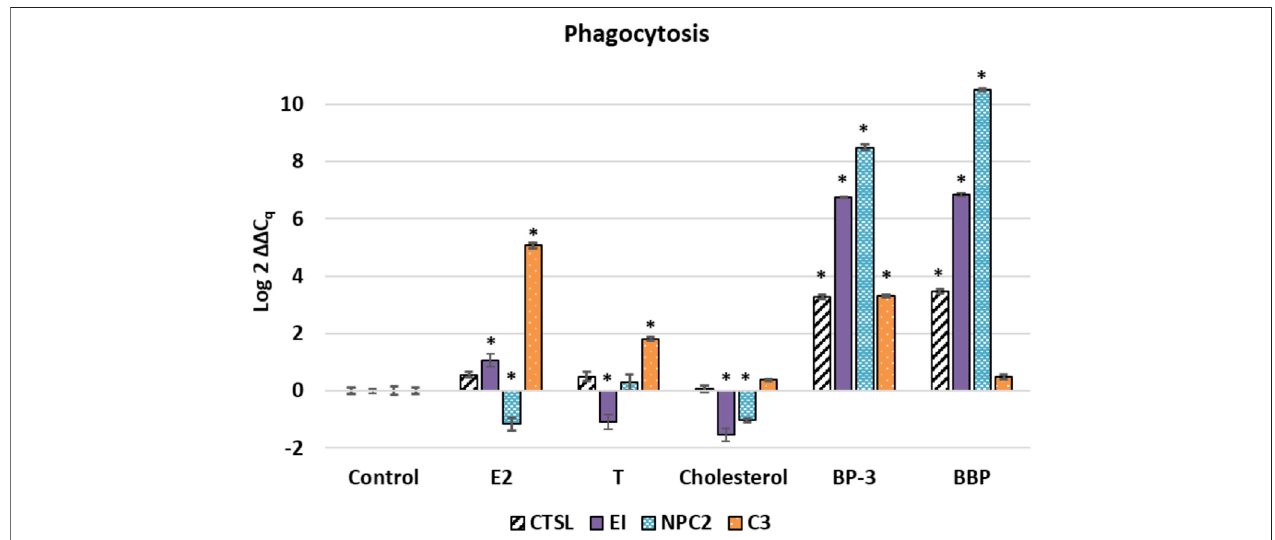
FIGURE2| Expressionpro fi leoftranscriptsassociatedwithphagocytosisandcellularstructuressuchassymbiosome,lysosome,orendosome.The ΔΔ Cqvalues represent transformed expression of a GOI relative to RPL11 expression. An * represents a treatment that was signi fi cantly different ( p < 0.01) relative to the control condition. Error bars represent ± SE. E2:estradiol; T: testosterone; BP-3: oxybenzone; BBP: benzyl butyl phthalate. CSTL: cathepsin L; EI: equistatin; NPC2: Niemann- Pick C type 2; C3: complement component C3.